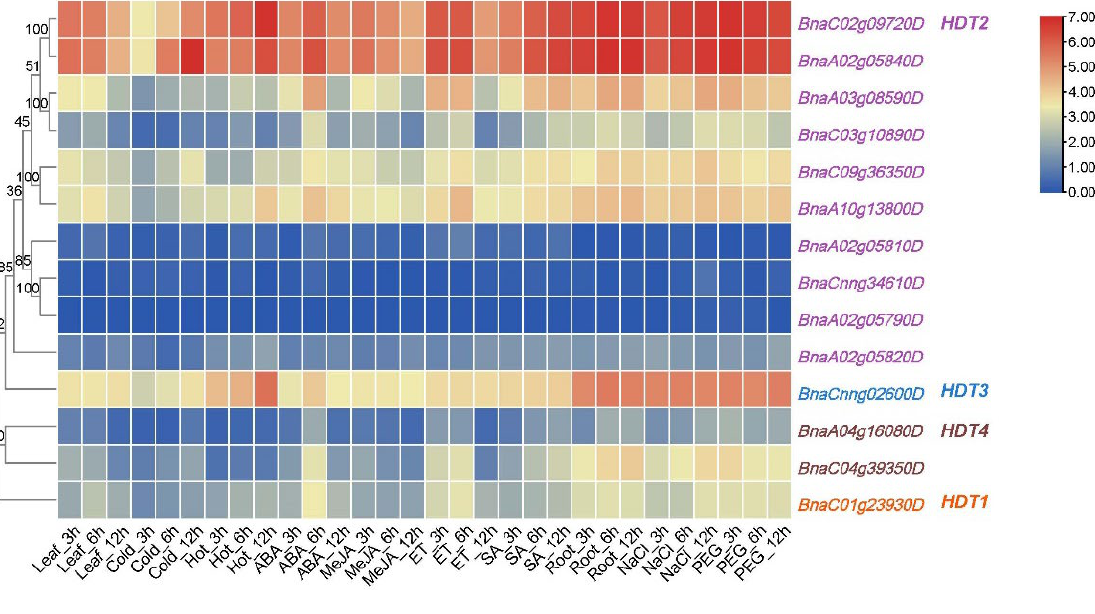
Gene name color: Red represents BnaHDT1 , purple represents BnaHDT2 , blue represents BnaHDT3 , and brown represents BnaHDT4